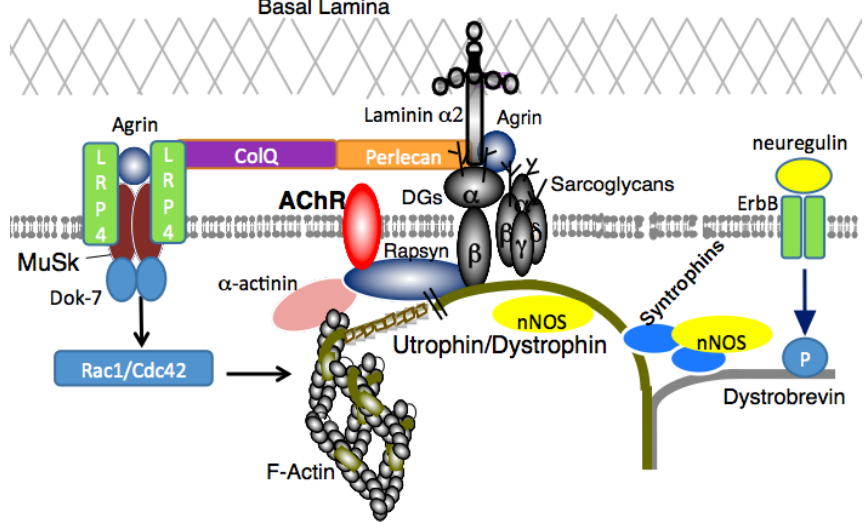
Figure 7. The utrophin/dystrophin protein complex and AChR. Acetylcholine Receptors ( AChRs) are connected to the utrophin/dystrophin-associated protein complex by rapsyn, which is essential for AChR stabilization. AChR, acetylcholine receptor; ColQ, collagen Q; DG, dystroglycan; ErbB, erythroblastic leukemia viral oncogene homolog; LRP4, low-density lipoprotein receptor-related protein 4; MuSK, muscle-specific kinase; nNOS, neuronal nitric oxide synthase. This localization occurs at the neuromuscular